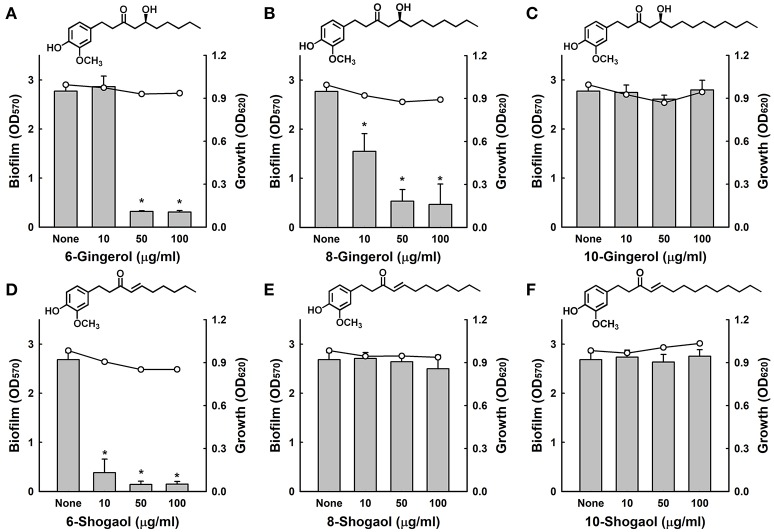
Antibiofilm activities of gingerols and shogaols against C. albicans. The antibiofilm activities of three gingerols (A–C) and three shogaols (D–F) against C. albicans DAY185 in PDB medium were determined after culture for 24 h. Bars indicate biofilm formation and lines indicate planktonic cell growth. The chemical structures of gingerols and shogaols are shown. *P < 0.05 vs. non-treated controls. None; non-treated control.